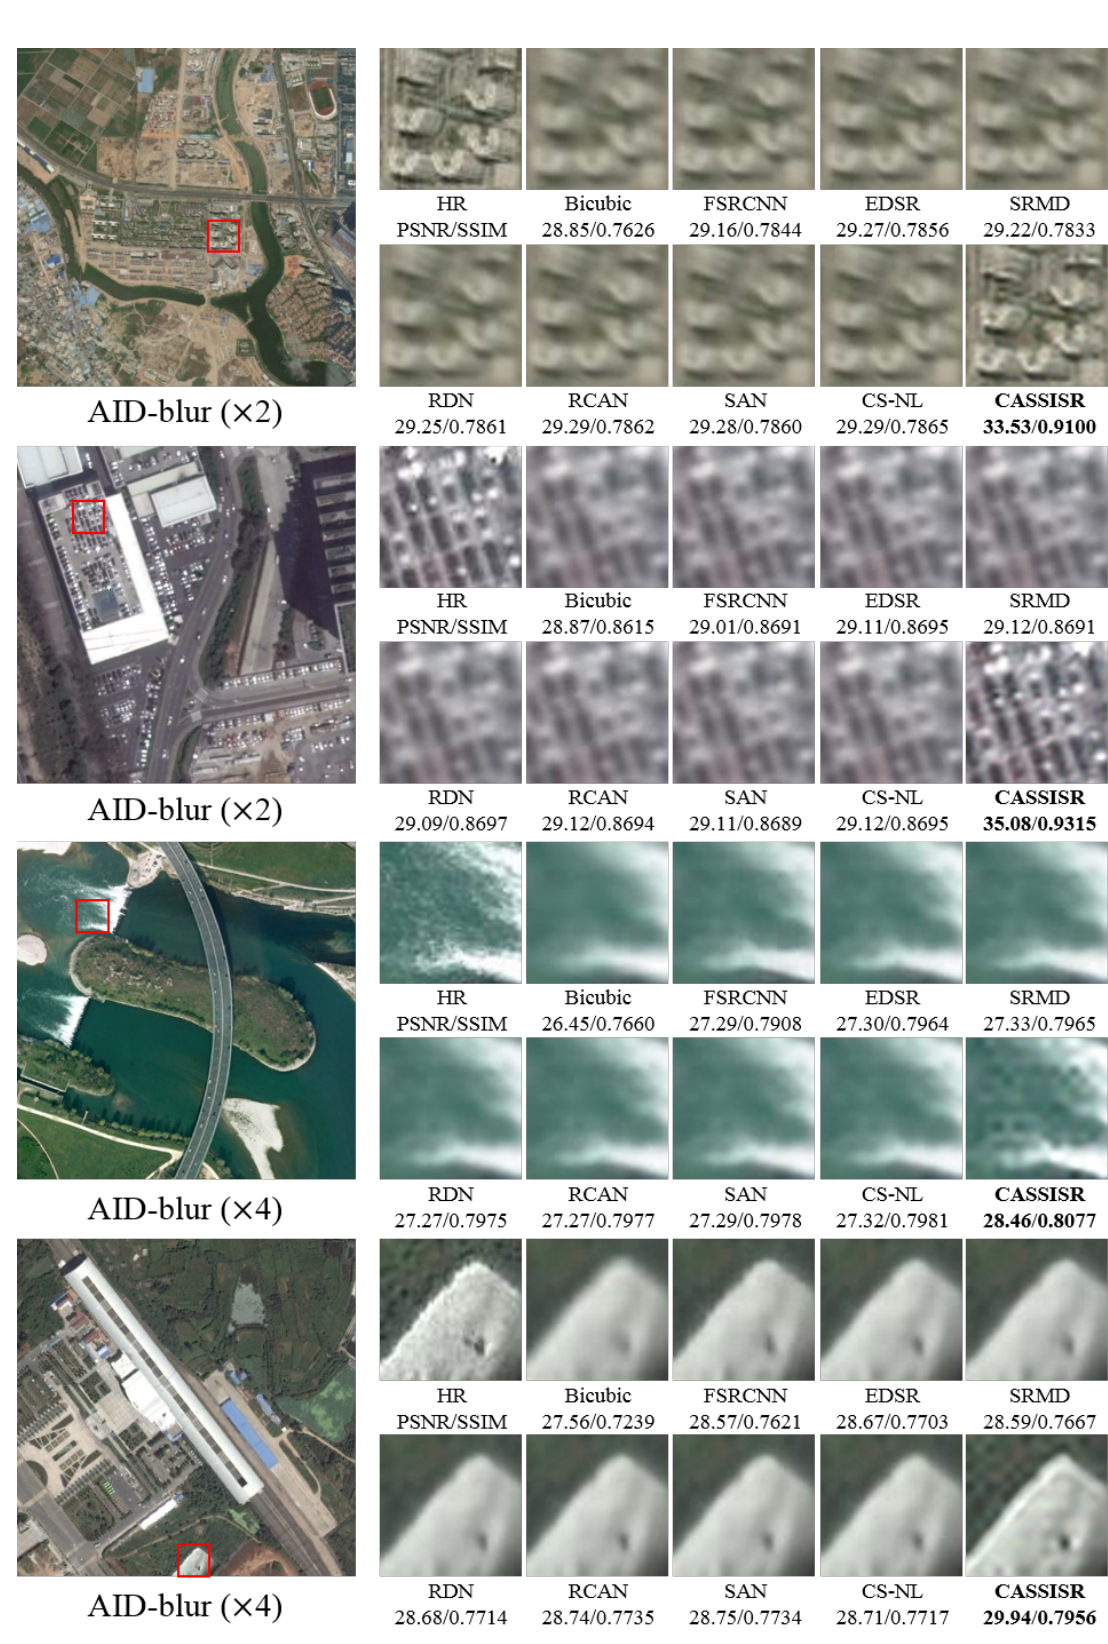
Figure 8. Qualitative comparison of scaling factors × 2 and × 4 between CASSISR and CNN-based SR methods on AID-blur dataset. Our CASSISR results are highlighted